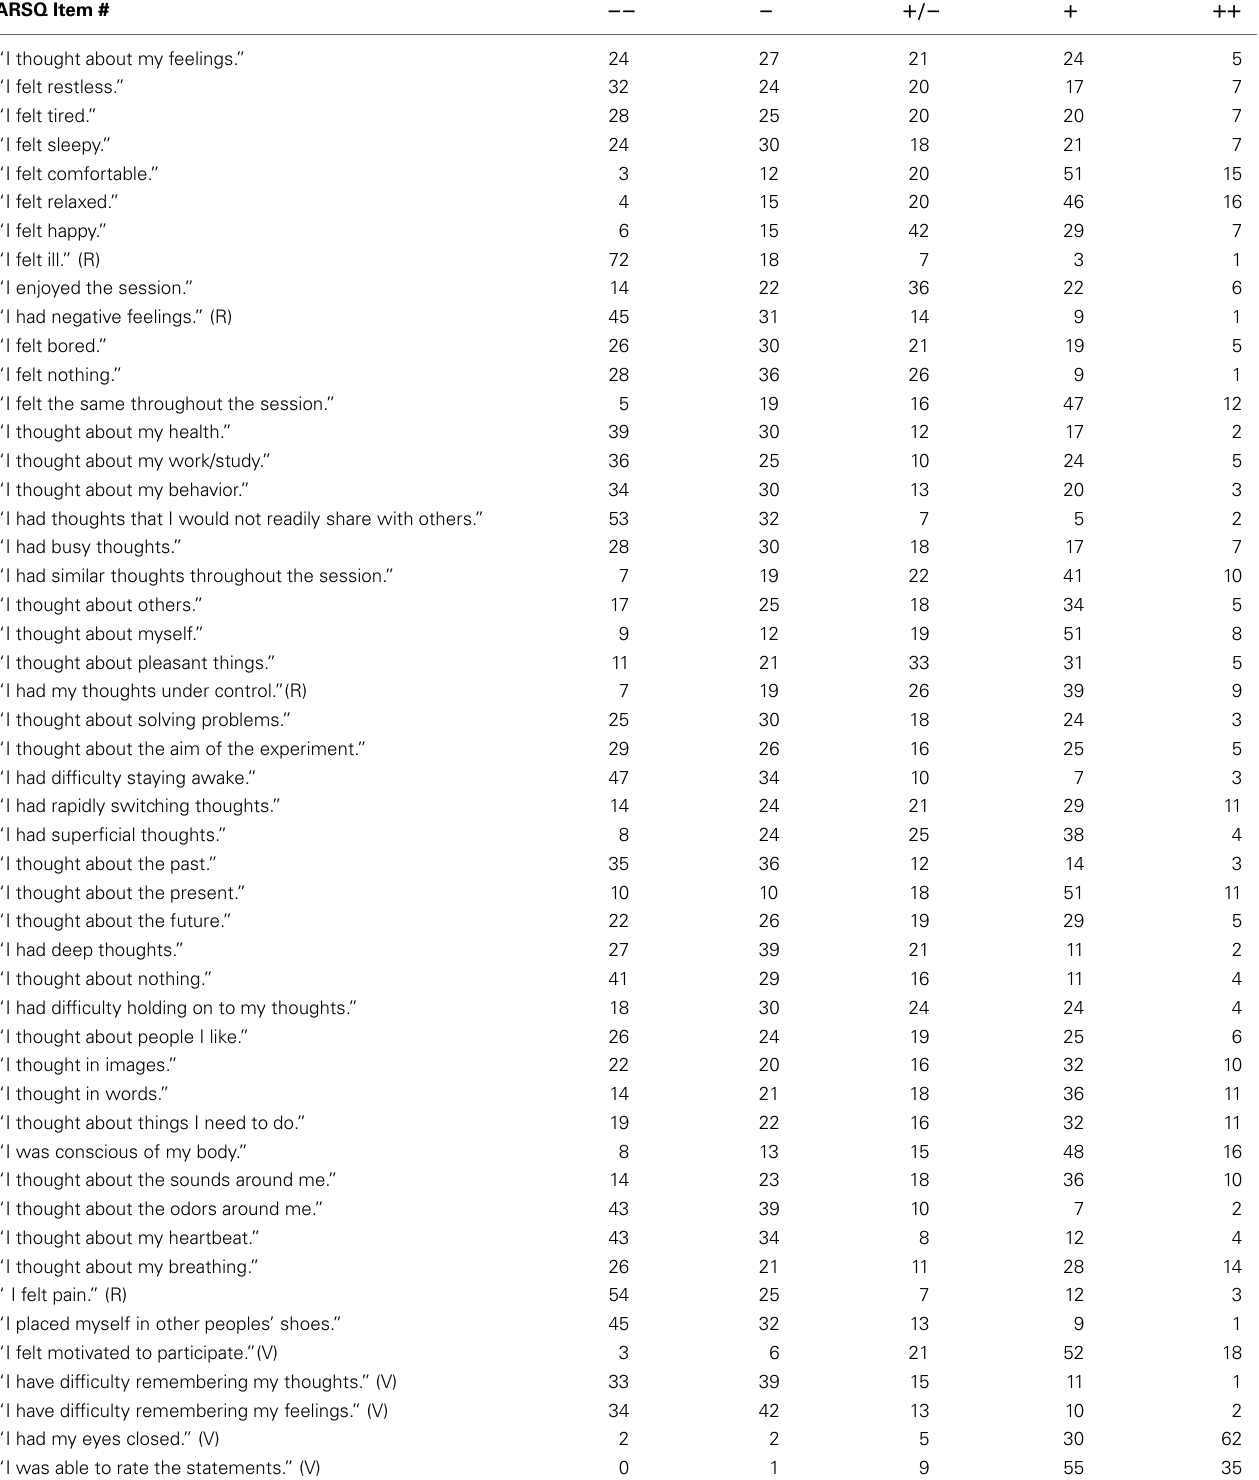
Table 1 | Endorsement rate of ARSQ items ( n = 1367, complete data set). ARSQ Item